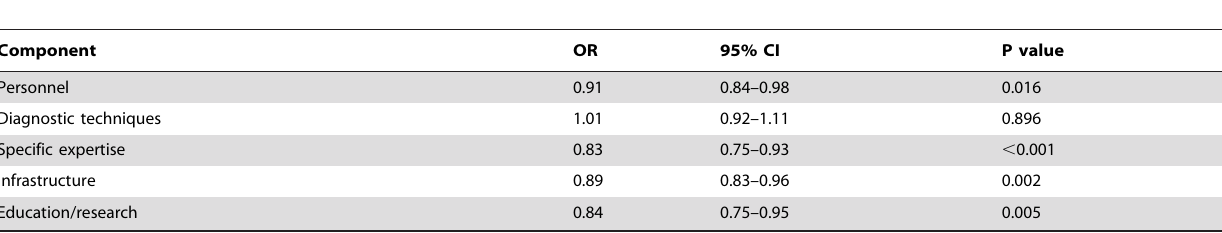
Table 9. The impact of subcategory CSC score on in-hospital mortality after subarachnoid hemorrhage adjusted by age, sex and